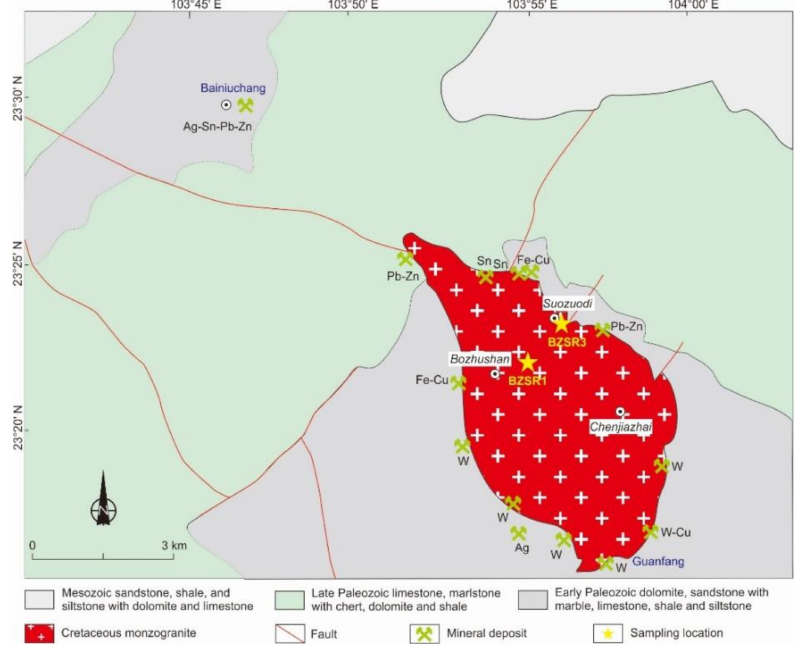
Figure 2. Simplified geological map of the Bozhushan Sn–W polymetallic ore